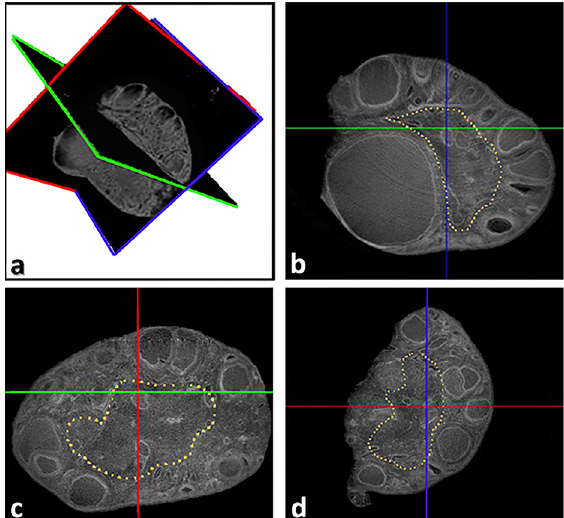
Figure 3 - Reconstructed microCT images of the cow ovary in 3D showing good definition of cortex, medulla and antral follicles. a: 3D image showing virtual sections of the three axis: sagittal (red), axial (blue) and coronal (green). b: Virtual section of the sagittal axis. c: Virtual section of the axial axis. d: Virtual section of the coronal axis. The medullar region is highlighted by a dotted line. Several antral follicles are present in the cortex.